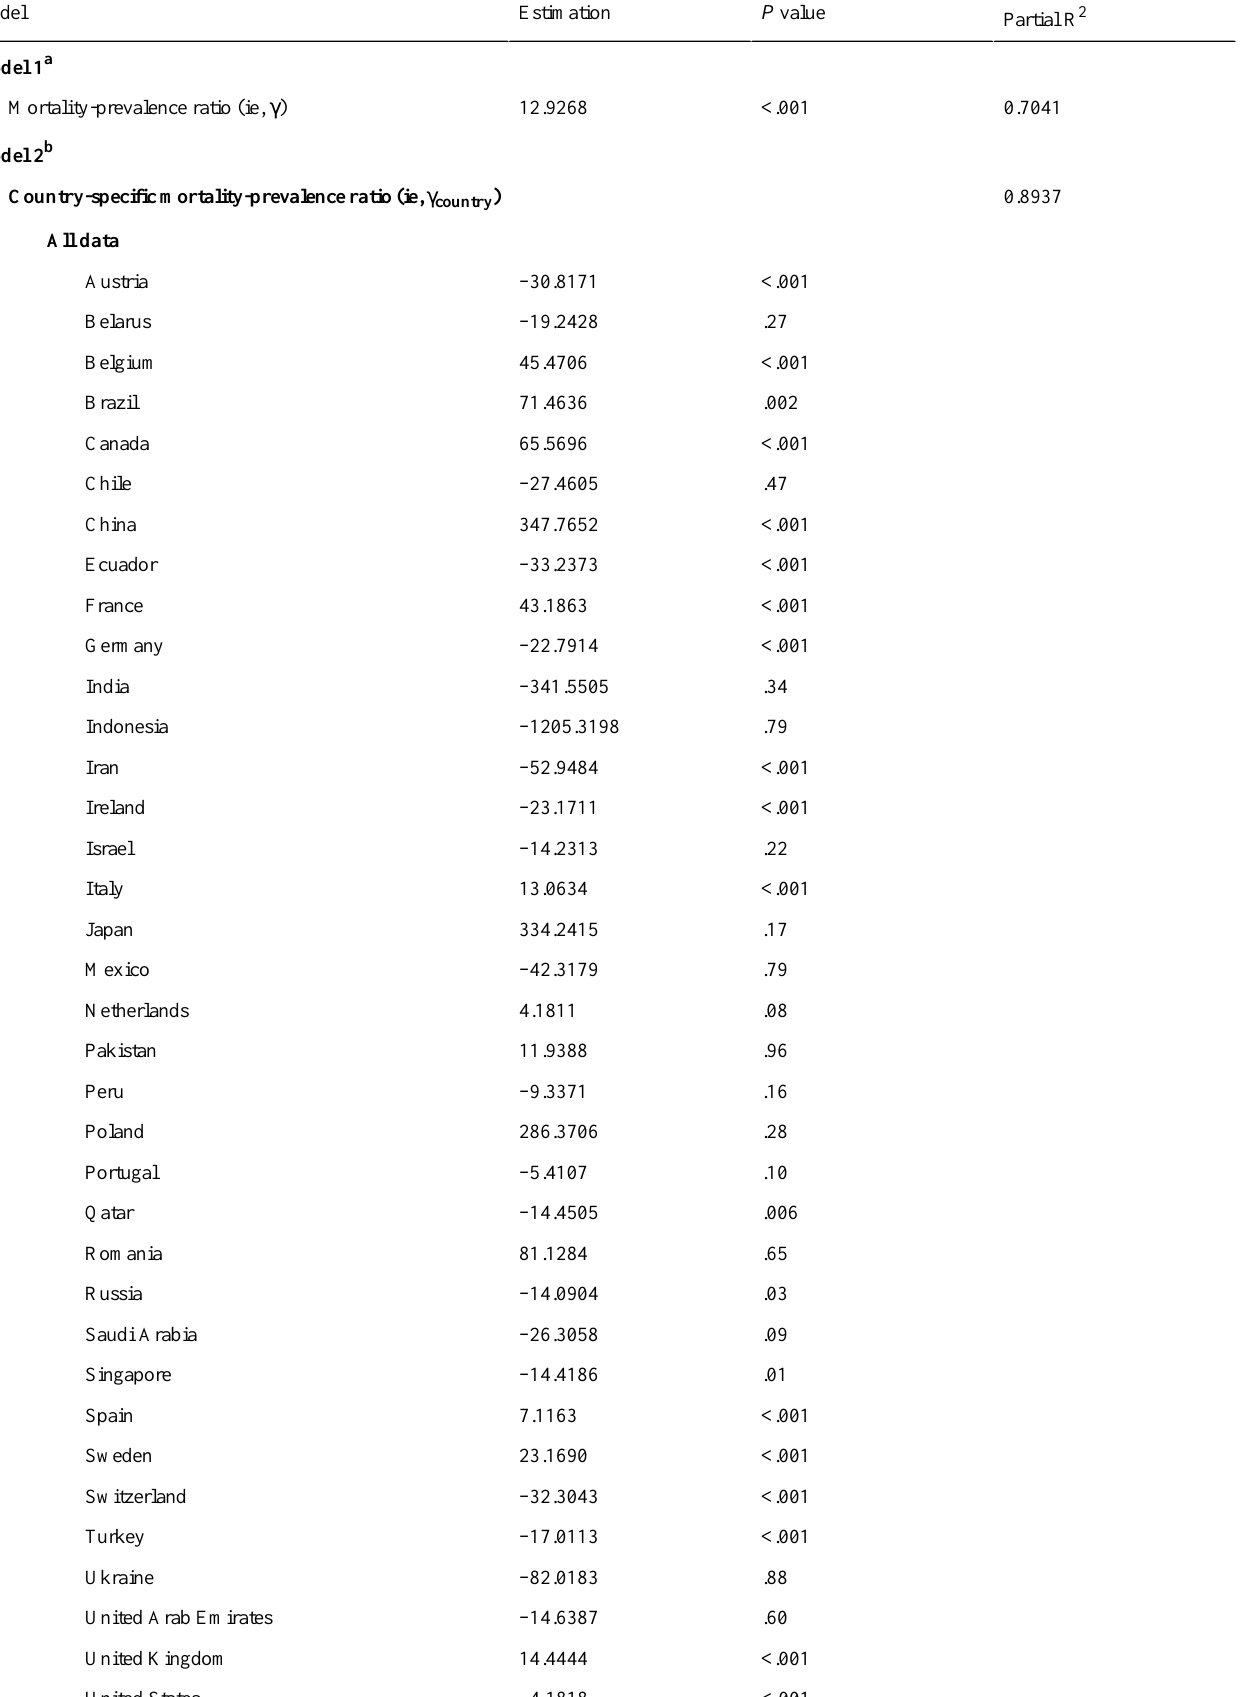
Table 2. Estimation of all coefficients for Model 1 and Model